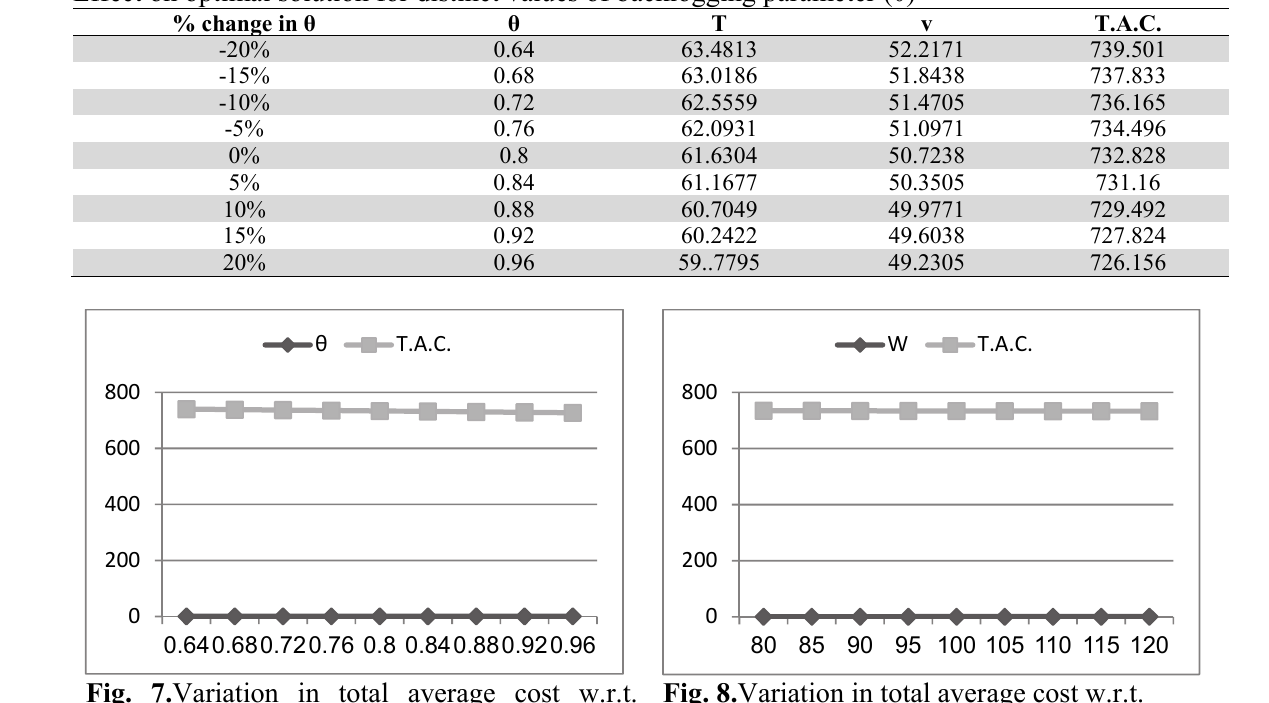
Fig. 8. Variation in total average cost w.r.t. warehouse capacity (W)